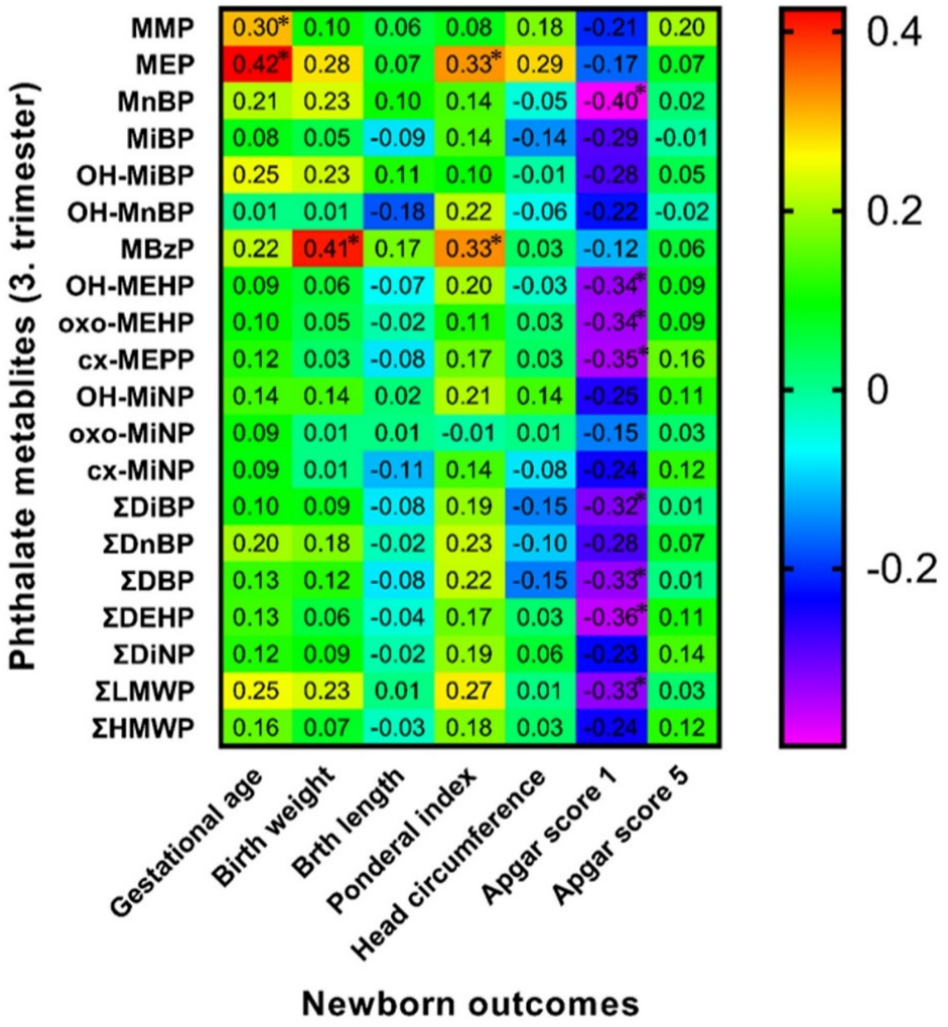
Figure 4. Correlation matrix of boy-newborn outcomes and maternal phthalate metabolites during third trimester of pregnancy. Legend is shown in the footnote of Table 4. * The correlation is significant at the level p ≤ 0.05.